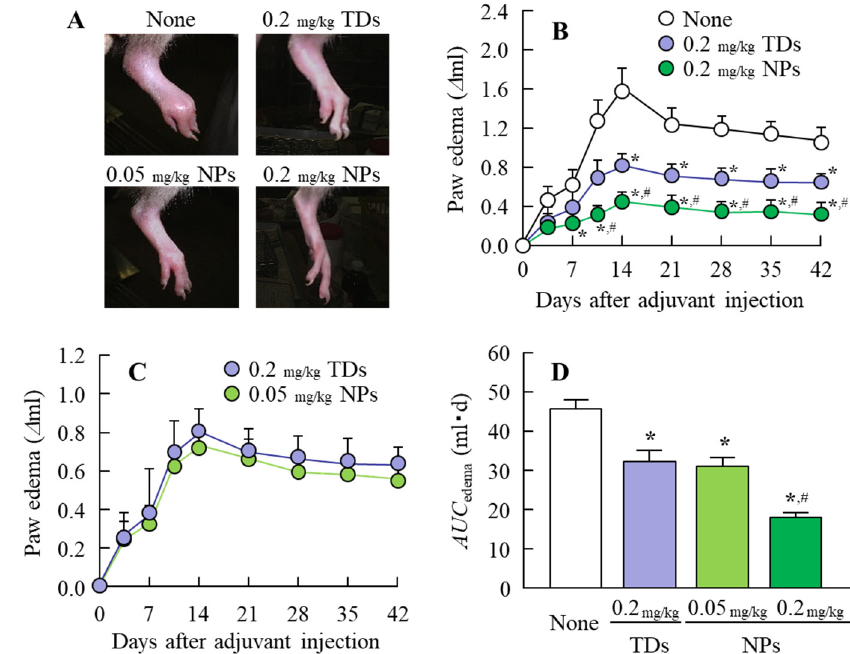
Figure 6. The therapeutic effect of MLX-NPs in AA rats. ( A ) Image of paw edema of AA rats orally administered MLX formulations. ( B ) Changes in paw edema of rats orally administered 0.2 mg/kg MLX-TDs or MLX-NPs. ( C ) Changes in paw edema of AA rats orally administered 0.2 mg/kg MLX-TDs or 0.05 mg/kg MLX-NPs. ( D ) AUC edema of AA rats orally administered 0.2 mg/kg MLX-TDs or 0.05 mg/kg or 0.2 mg/kg MLX-NPs. n = 8. * P <0.05 vs. None for each category. # P < 0.05 vs. 0.2 mg/kg